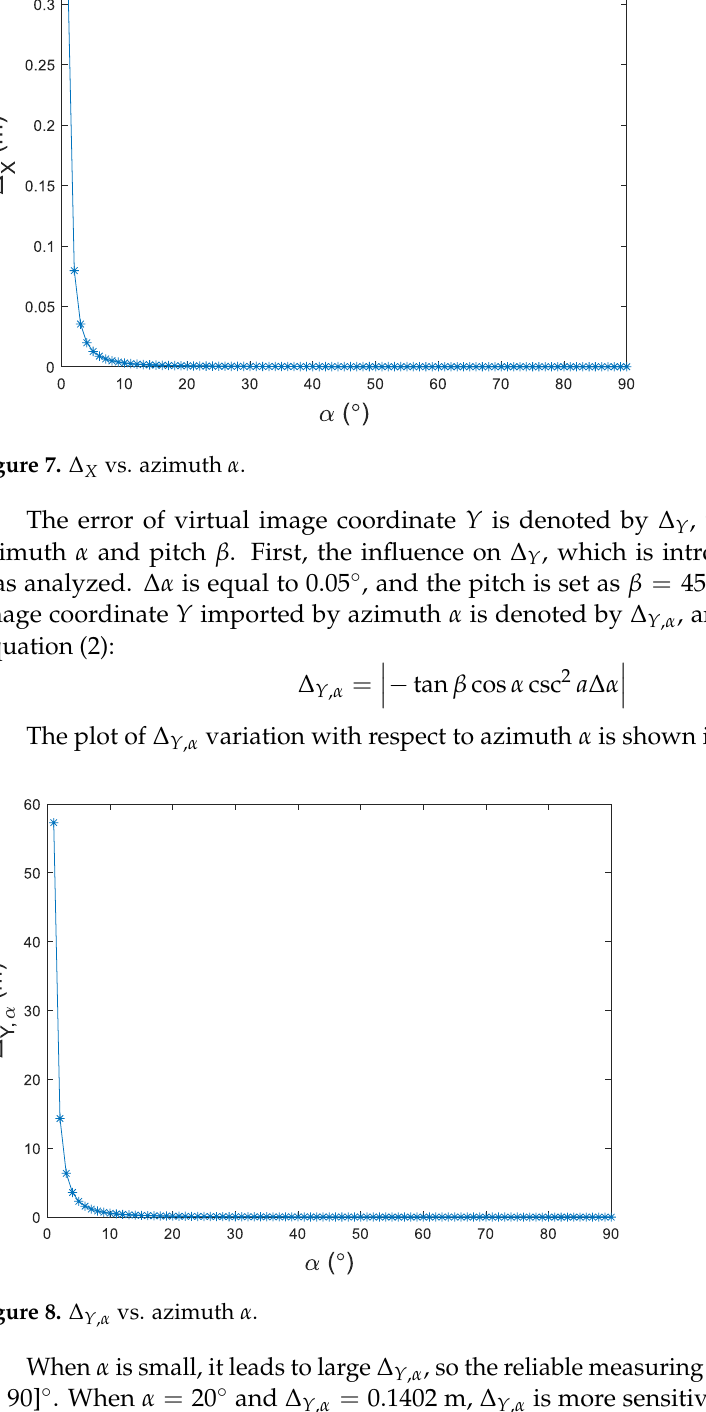
α . ∆ Y , α increases intensively with the decrease of α within the range α ∈ ( 0, 10 ] ◦ , which is